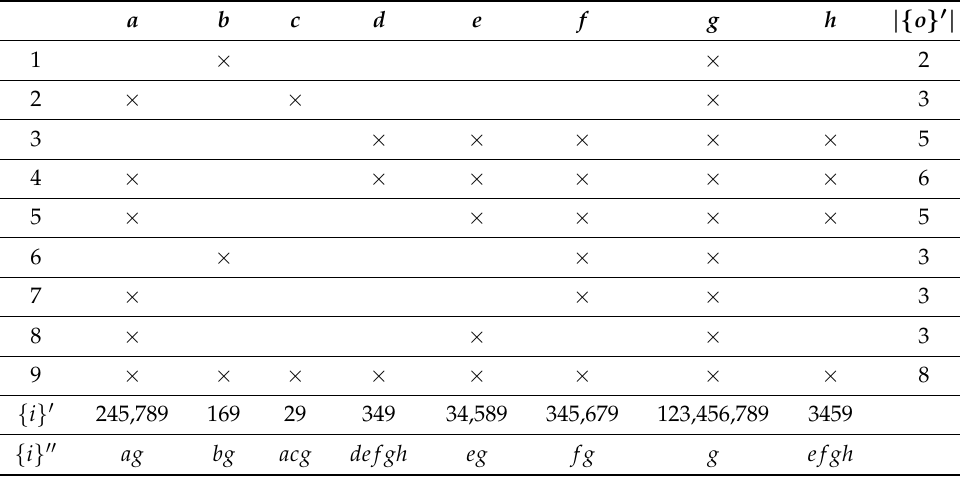
Table 6. The formal context given by Table 1 with additional